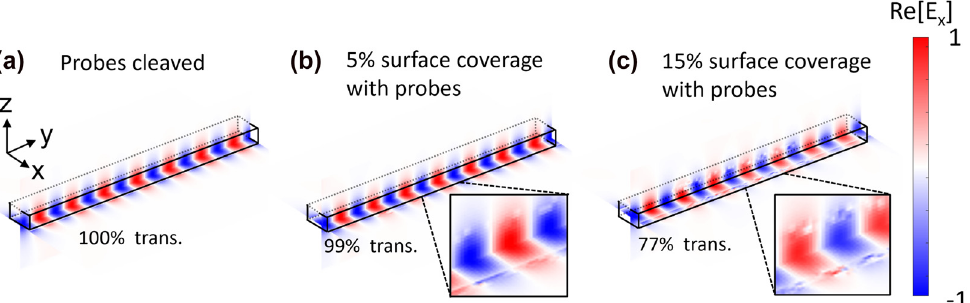
modes propagating through the straight silicon waveguide section. The straight Figure 3: Electric field snapshots of the fundamental TE 0 waveguide is surrounded by deionized water with refractive index of 1.333. The waveguide has 220 nm thickness and 500 nm width. The microfluidic channel, where the probes can be attached to the waveguide, extends over the length of 2550 nm along the waveguide. The real part of the electric field in the x – y dimension and y – z dimension is shown in (a) when the probes were cleaved, (b) when the probes cover 5% of the waveguide surface, (c) when the probes cover 15% of the waveguide